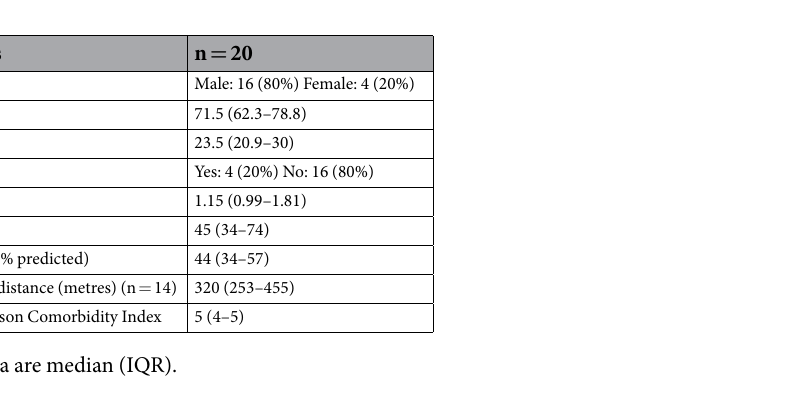
CT-measured intercostal density had a weak negative correlation with ultrasound measured intercostal echogenicity.